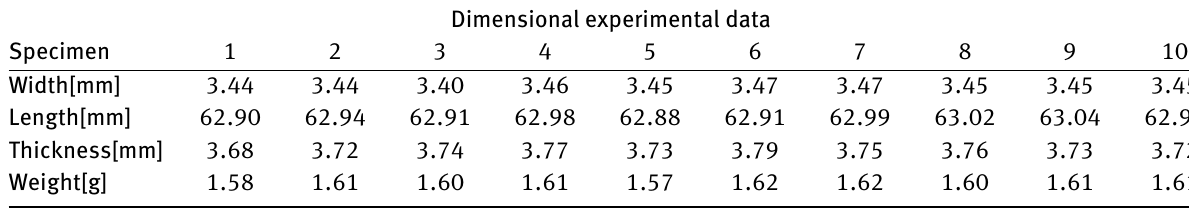
Dimensional experimental data